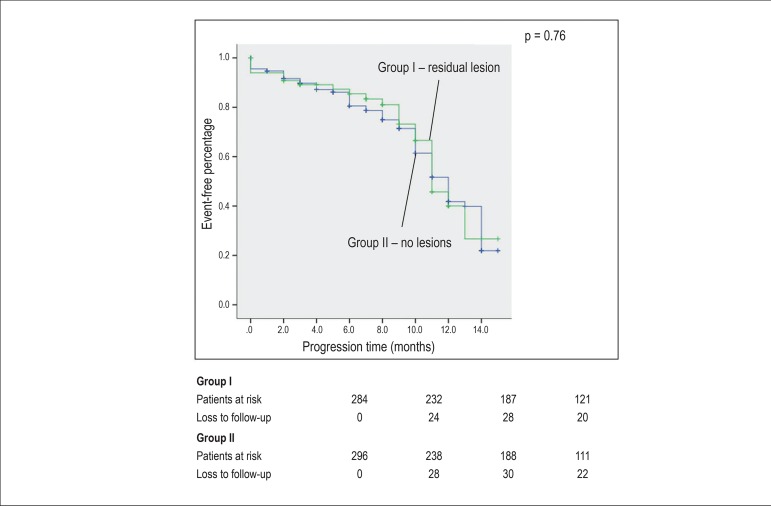
Comparison of percentage free of long-term combined events in group I
(with residual lesion) and II (without residual lesion).